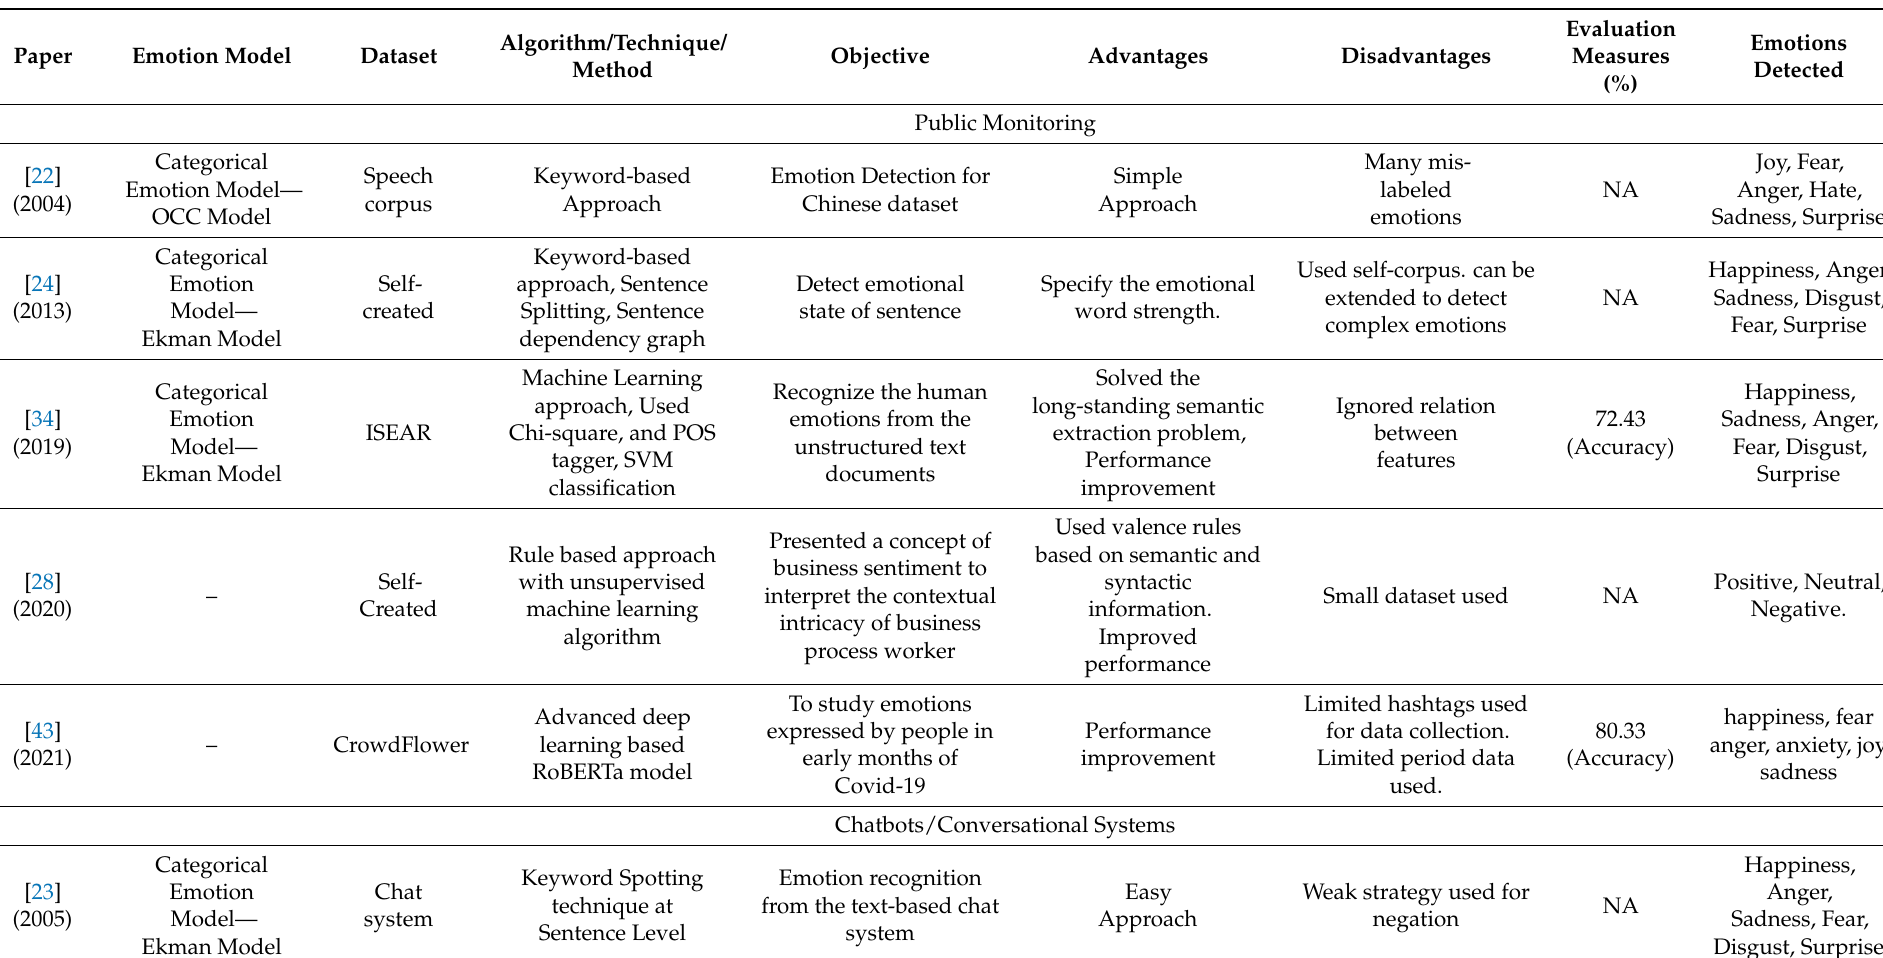
Table 2. Qualitative analysis of the relevant literature according to key